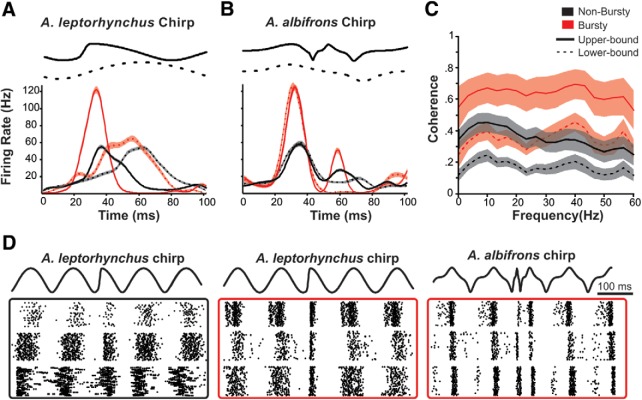
Coding of chirps by a small population of higher-pass neurons. A, The mean instantaneous firing rates of ON cells over the time course of chirp and beat stimuli. The difference in peak firing rate(FR) characterize a small population (n = 5, red) that bursts in response to A. leptorhynchus small chirps (beat responses: dashed lines; peak FR, 77.67 ± 7.11 Hz; chirp responses: solid lines; peak FR, 159.57 ± 8.68 Hz; Wilcoxon rank-sum test (p < 0.001). The majority of the ON-cell population (n = 16, black) only showed a modest increase in firing (beat response: peak FR, 62.68 ±1.27 Hz; chirp response: peak FR, 66.56 ± 4.21 Hz; Wilcoxon rank-sum test, p = 0.002). Shaded area represents SE. B, Even the bursty population fires less in response to A. albifrons smallest chirps compared with the beat (beat response: peak FR, 155.45 ± 8.82 Hz; chirp response: peak FR, 117.75 ± 9.40 Hz; Wilcoxon rank-sum test, p = 0.04). C, Mean (±SE) upper-bound and lower-bound coherences for the bursting (red) and nonbursting (black) populations. D, Example raster plots of chirp responses used for A and B. The nonbursty population (black box) responds similarly to both A. leptorhynchus chirp and beat. The bursty population (red box) bursts to A. leptorhynchus chirps, but not A. albifrons chirps. For comparable data obtained from A. leptorhynchus, see Extended Data Figure 5-1.